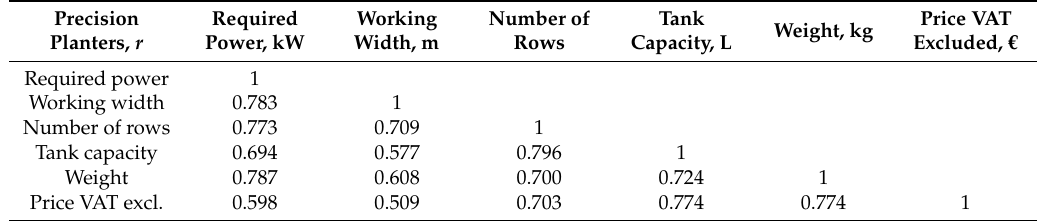
Table 9. Correlation matrix of Pearson coefficient r for functional parameters of precision planters.